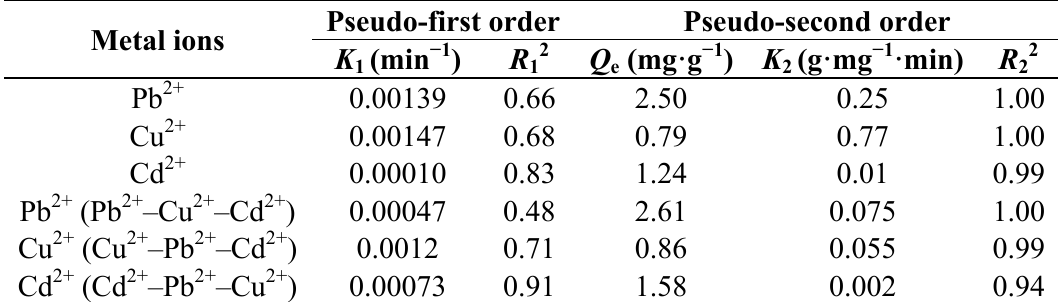
Table 2. Constants and correlation coefficients obtained by pseudo-first-order and pseudo-second-order kinetics models.